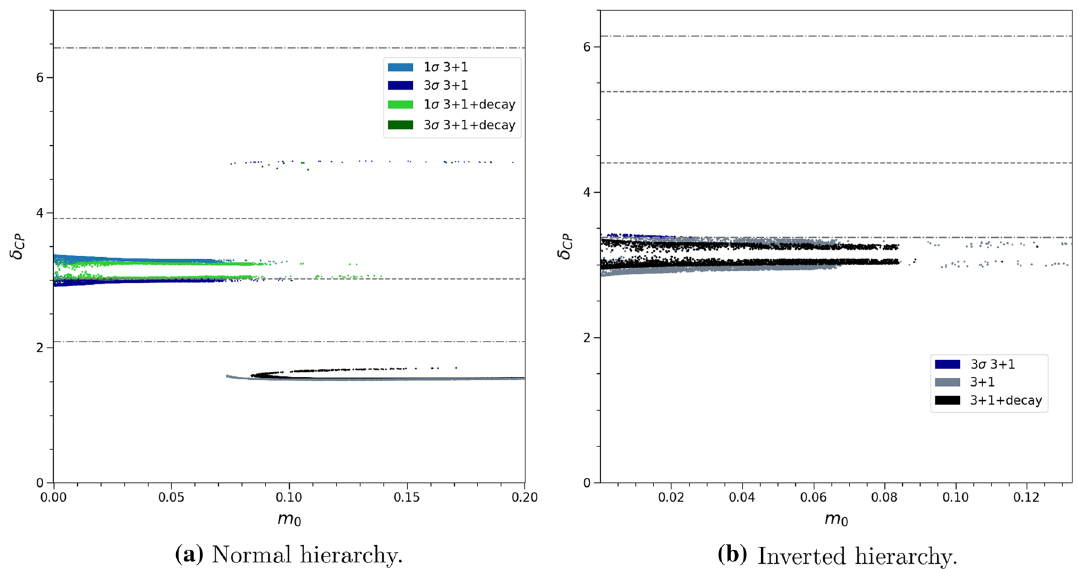
Fig. 2 Predictions for the Dirac phase δ CP as a function of the light- est neutrino mass m 0 for normal ( a ) and inverted ( b ) hierarchy. For the 3 + 1scenariolight(dark)bluedotsliewithinthecurrent1 σ (3 σ )region